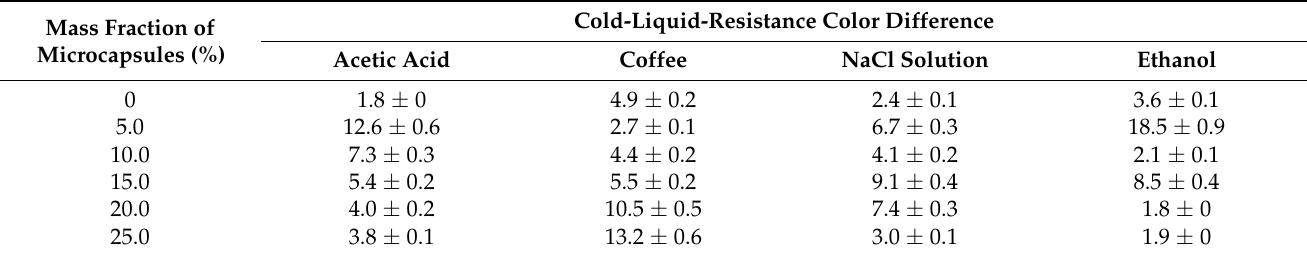
Table 11. The liquid-resistant color difference of coating with different microcapsules contents.